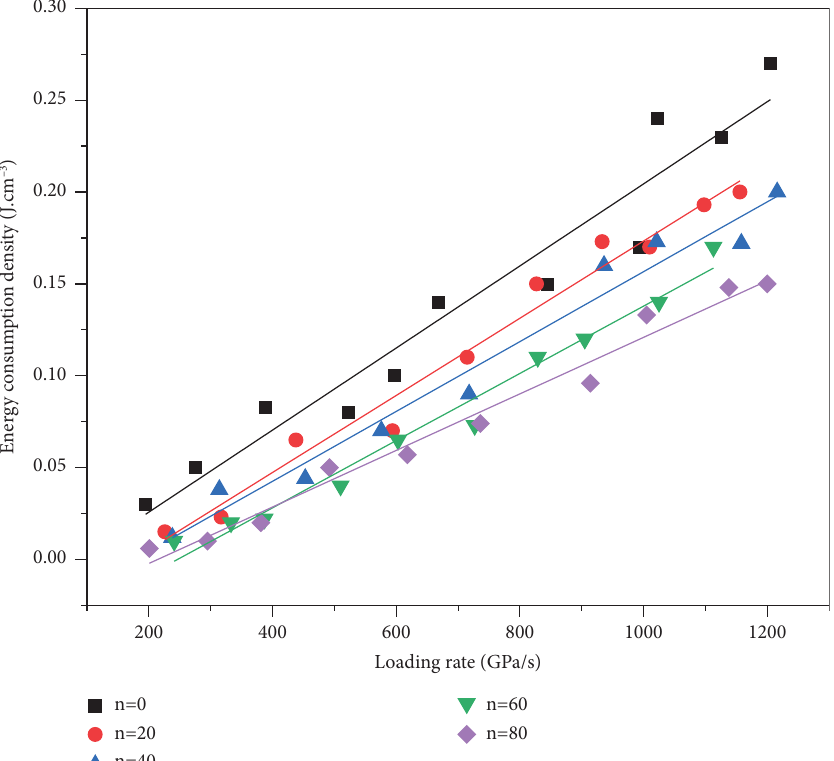
Figure 12: Energy consumption density of red sandstone samples versus the loading